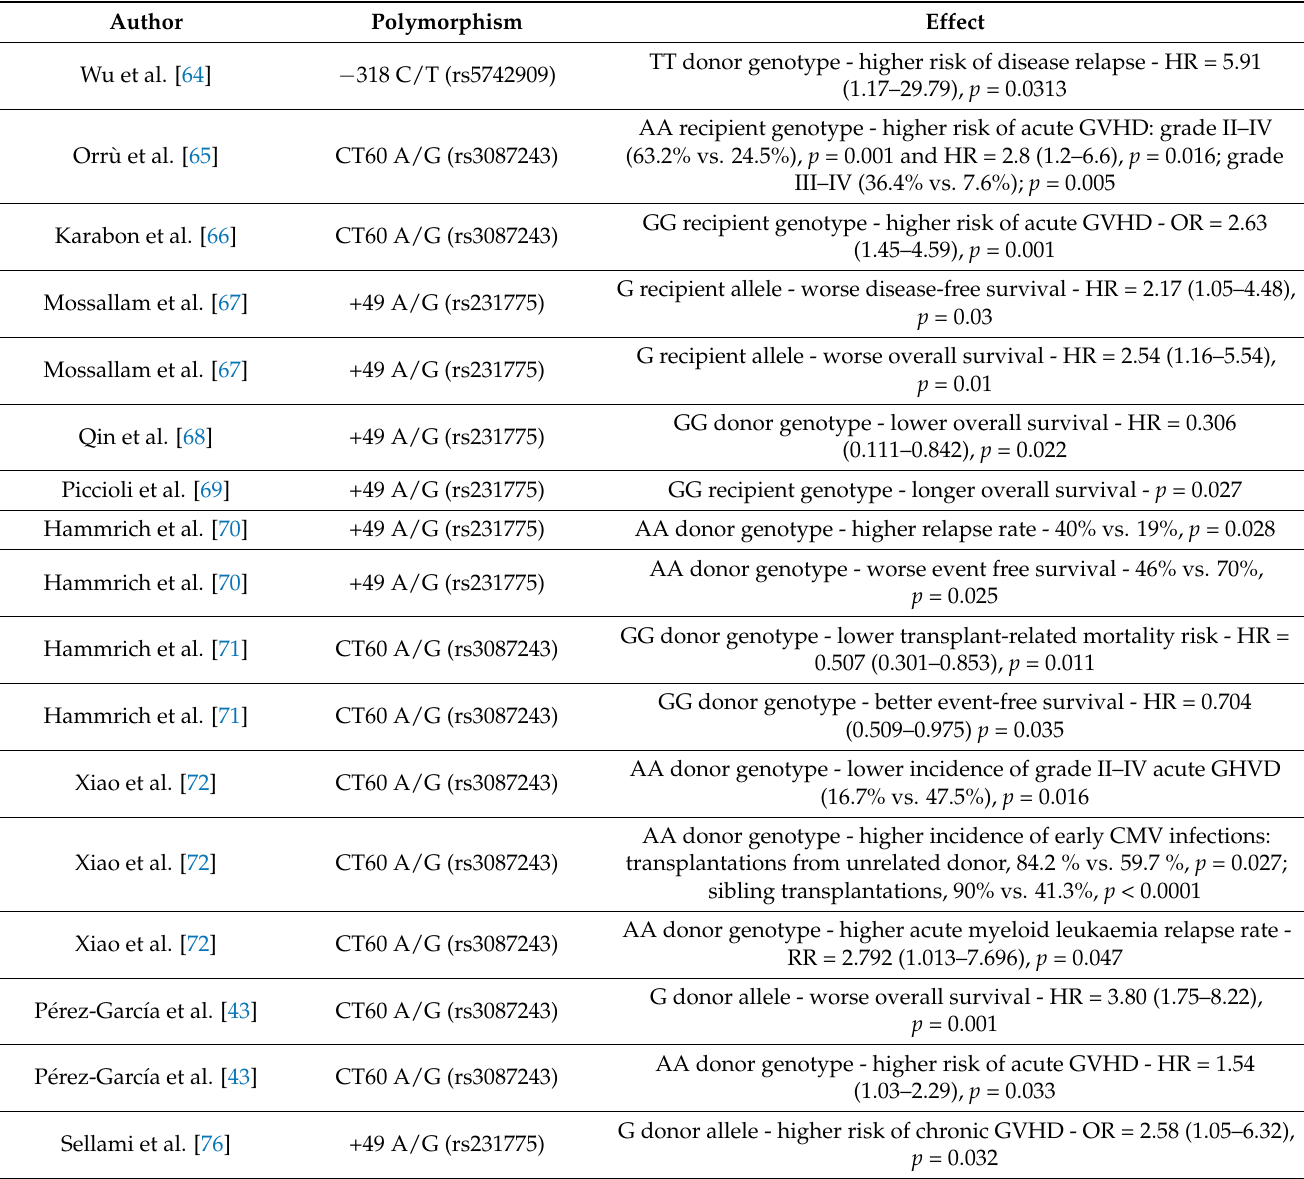
Table 2. The effect of CTLA-4 gene polymorphisms on allogenic haematopoietic stem cell transplantation outcomes, with regard to either donor or recipient